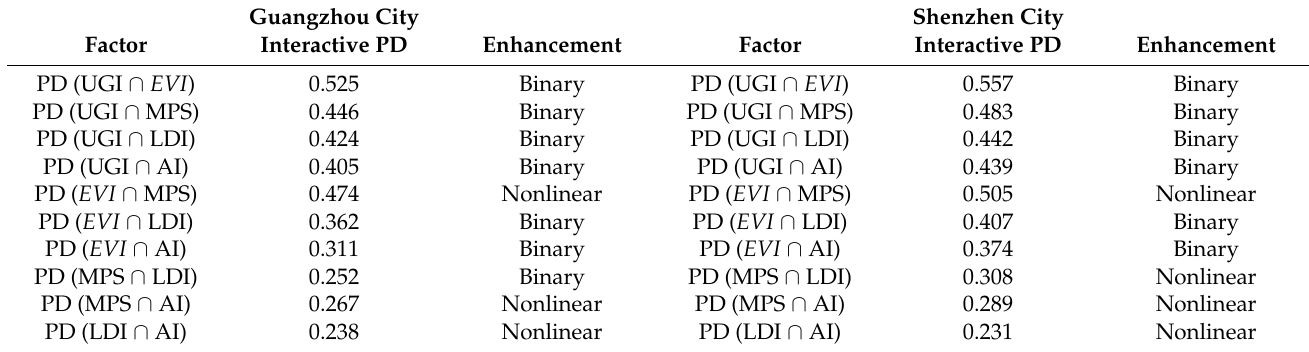
Table 7. Partial correlation coefficients between UGI and